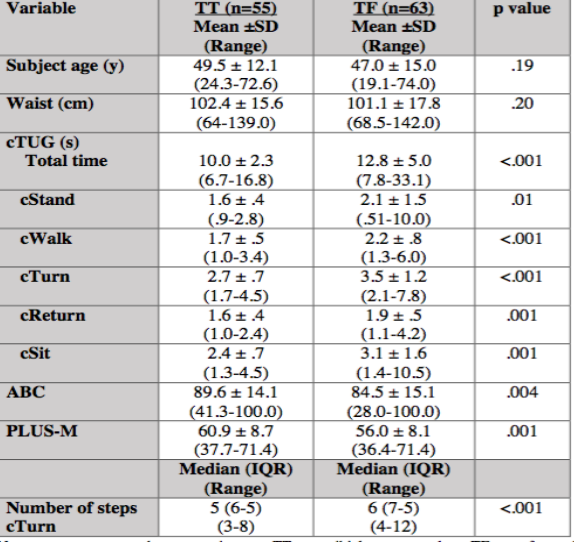
Table 1. Known-groups validity of the